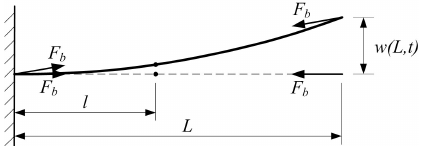
Figure 2. Detailed view of the geometry of the analytical actuator